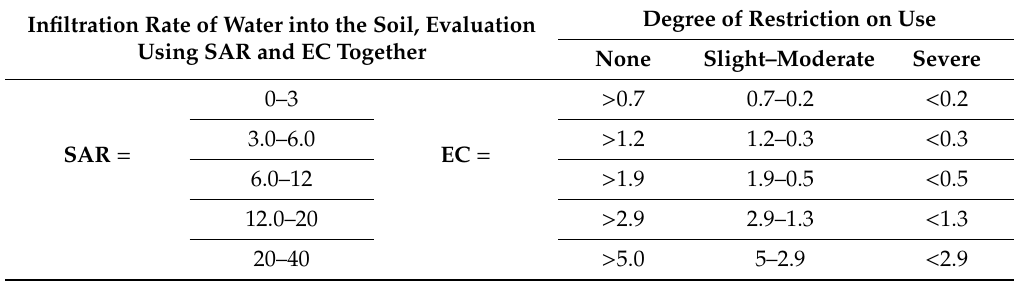
Table 5. Degree of restriction on use based on evaluation of SAR and EC